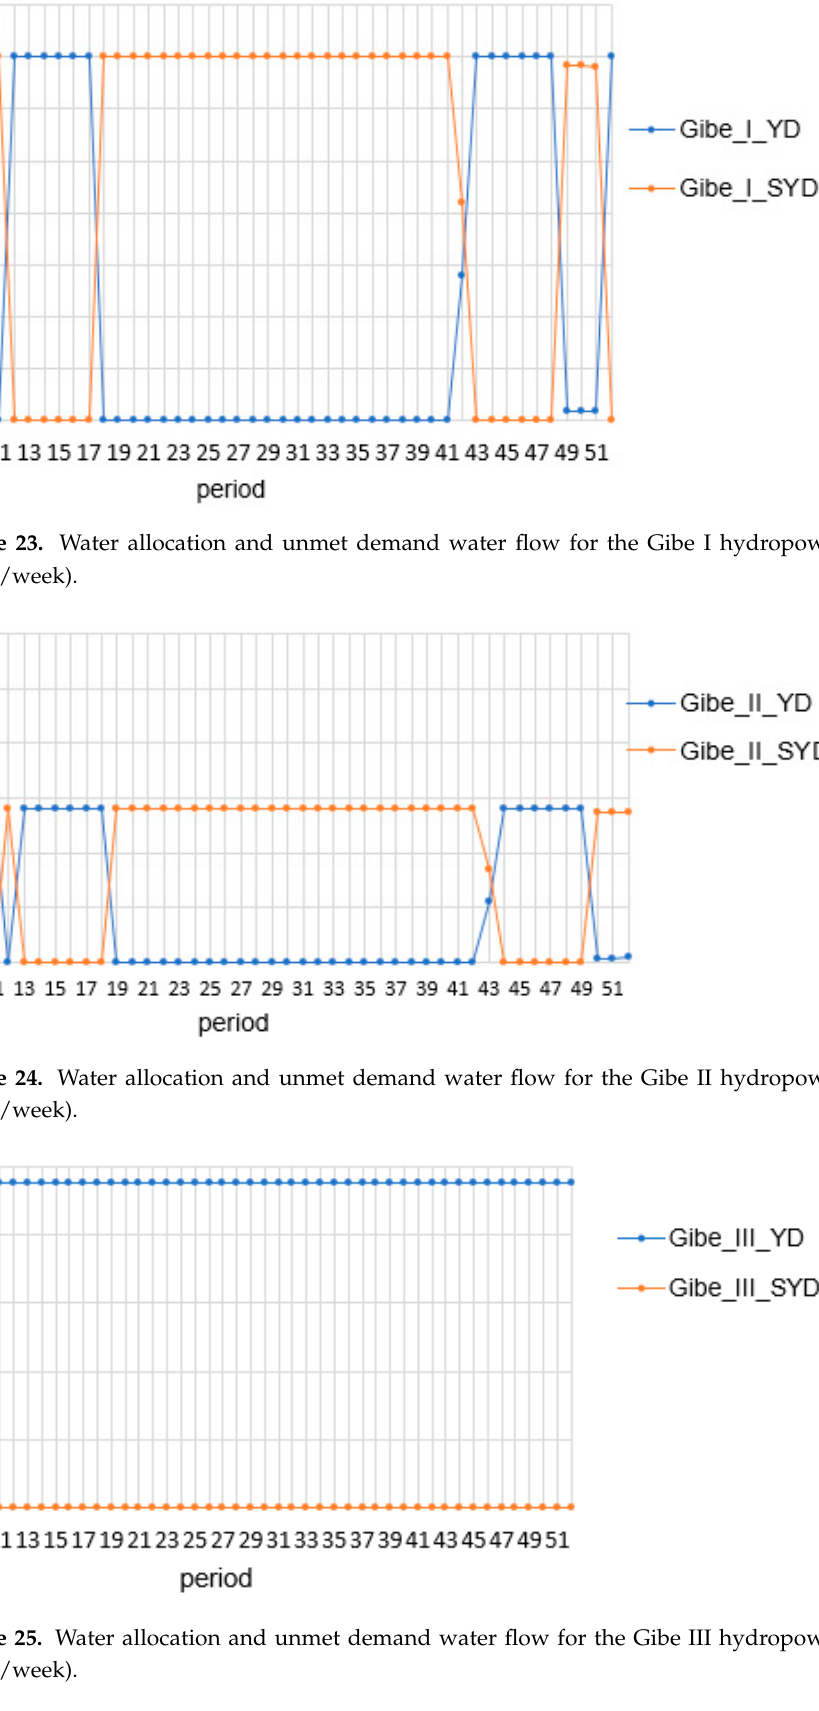
Figure 26. Water allocation and unmet demand water flow for the Gibe IV hydropower station (Mm 3 /week).